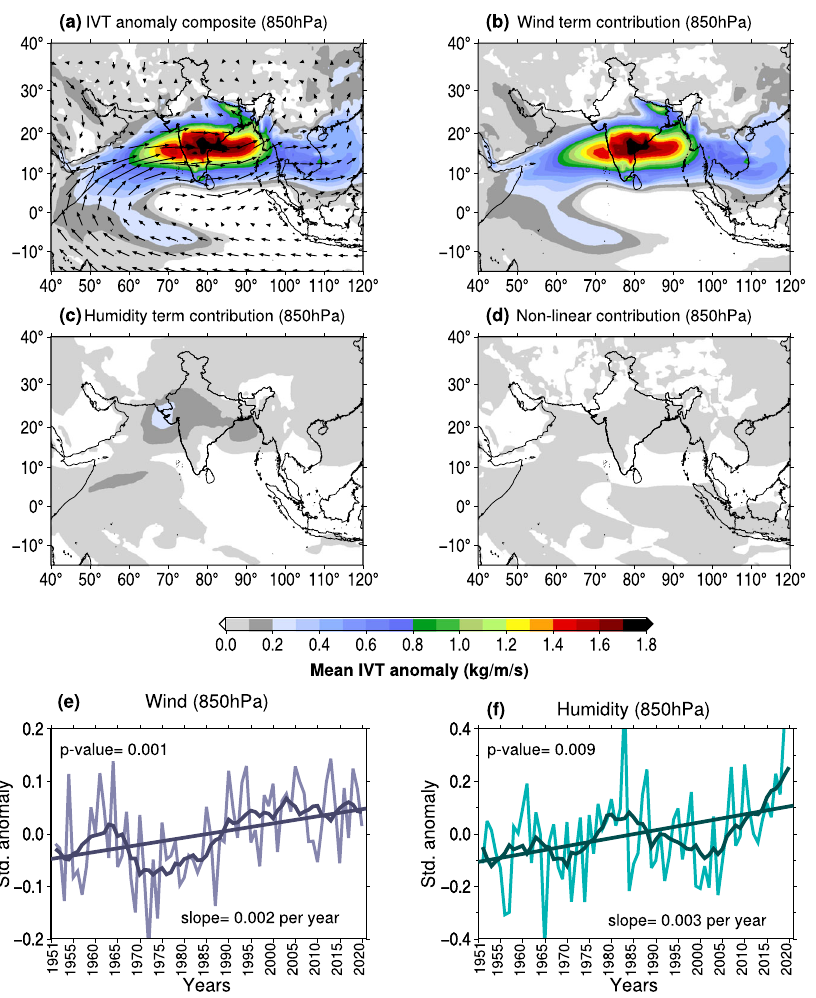
Fig. 2 Major drivers of changes in IVT during 1951 – 2020. a IVT anomaly composite for atmospheric rivers during the summer monsoon in India at 850hPa level (valid between the 1000 – 675 hPa range 68 ), b contribution to IVT from wind at 850hpa, c contribution in IVT due to speci fi c humidity, and d contribution due to nonlinearity between wind and speci fi c humidity based on the mass decomposition method 67 , and ( e , f ) trends in standardized anomaly of wind and speci fi c humidity during the summer monsoon season for 1951 – 2020 period. Lines in ( e , f ) represent the linear trend and 10-year moving average. Trend and change (trend slope multiplied by duration) were estimated using the non-parametric Mann-Kendall trend test and Sen slope estimator. Statistical signi fi cance was estimated at 5% level, therefore, p < 0.05 shows signi fi cant